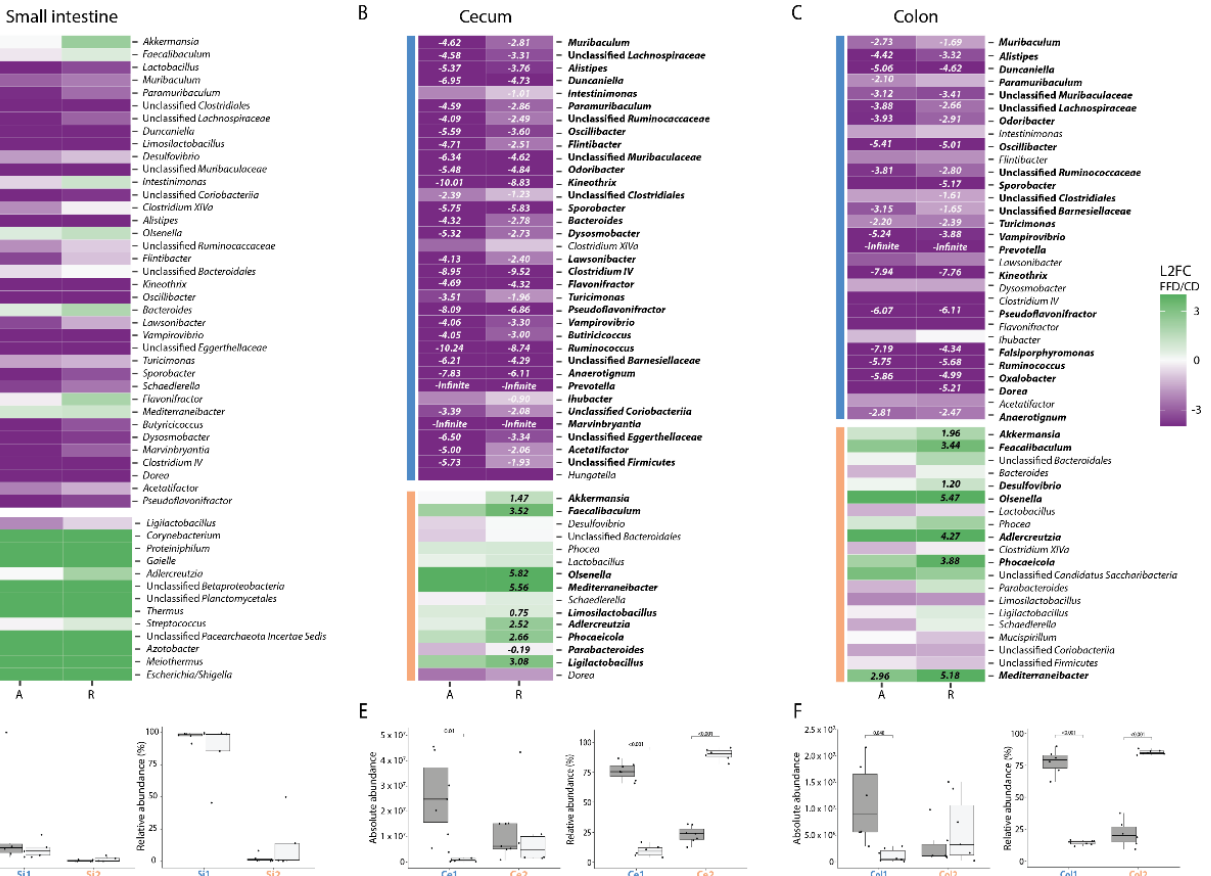
Figure 4. Dietary fiber deprivation induces significant shifts in the composition of the intestinal microbiota. ( A – C ) Log-base-2-fold change (L2FC) of each genus with respect to different diets (fiber- deficient/control) in each intestinal compartment, for both absolute (A) and relative (R) abundances. Taxa with significant L2FC values are printed and the L2FC value is given. Taxa are split by concor- dance group (i.e., cluster) and ranked from highest to lowest mean abundance. The absolute and relative abundances of taxa are grouped by cluster, diet, and compartment and displayed in box plots showing the group median and interquartile range, with each dot representing a single sample. Dark grey indicates the control diet, light grey the fiber-free diet. ( A ) + ( D ) for the small intestine, ( B ) + ( E ) for the cecum, ( C ) + ( F ) for the colon. Taxa that co-vary in abundance across samples may have similar environmental niche preferences, be involved in similar metabolisms, and/or be interacting with one another [50], and can be considered to be an ecological guild [51]. Co-variances in